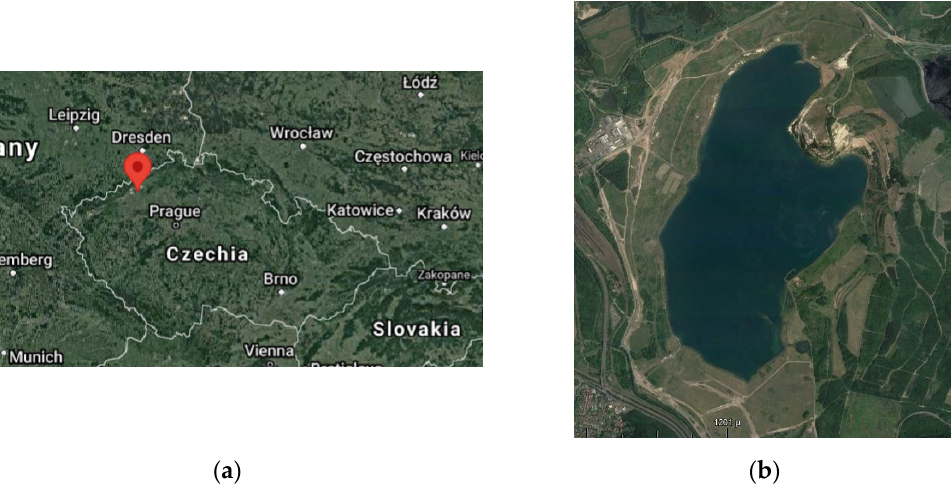
Figure 3. ( a ) Location of Lake Most in Czech Republic; ( b ) map of Lake Most (Google earth).